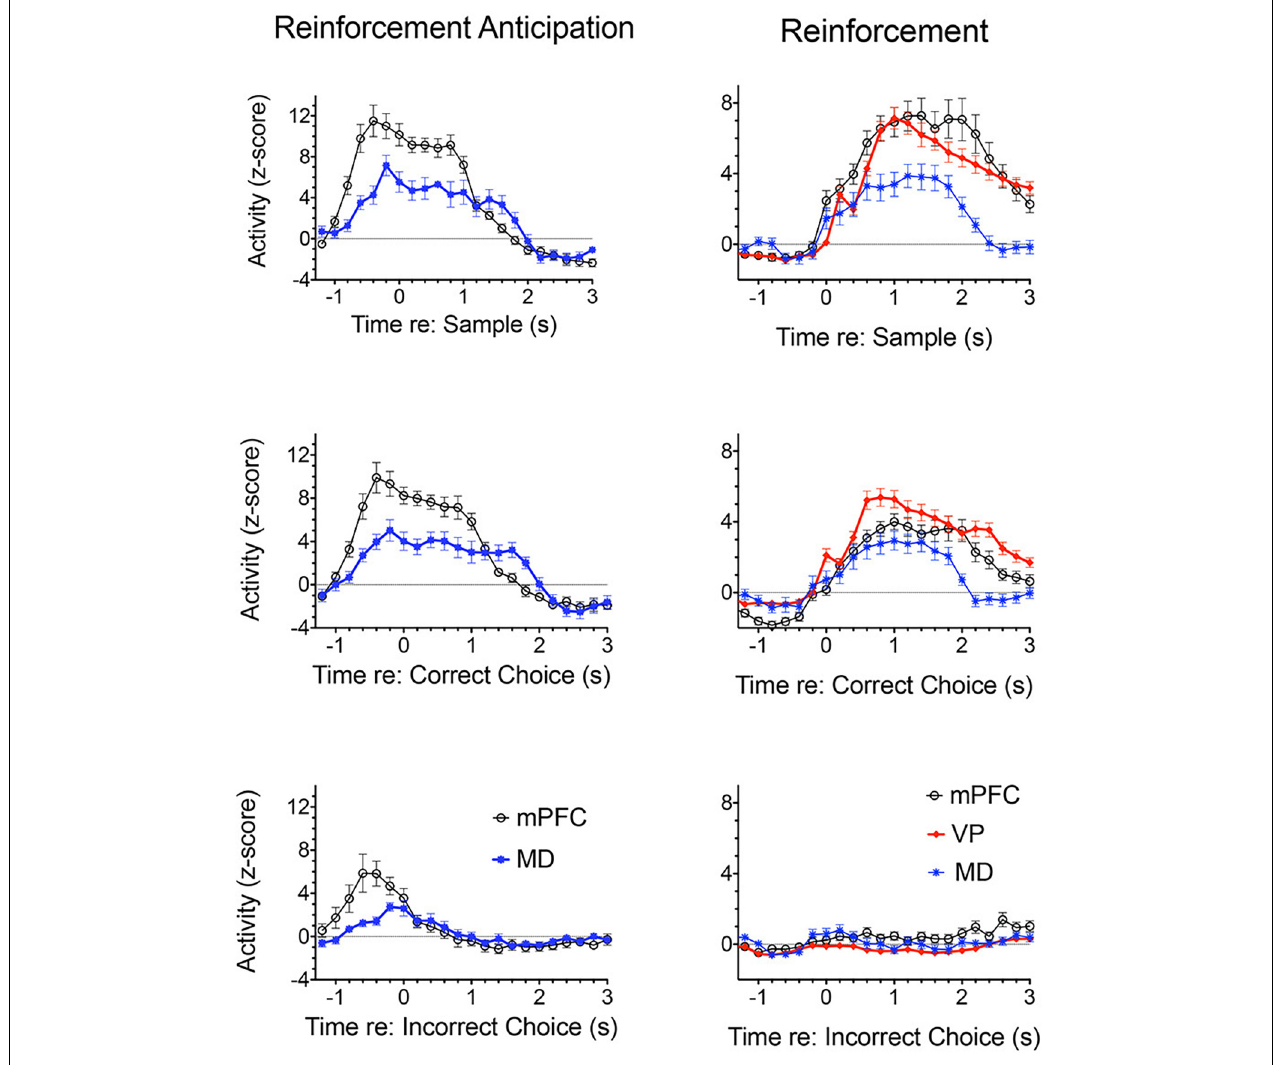
FIGURE 3 | Normalized population histograms responses related to reinforcement delivery in medial prefrontal cortex (mPFC; n = 63), the mediodorsal thalamic nucleus (MD, n = 71), and ventral pallidum (VP, n = 101) and reinforcement anticipation in mPFC ( n = 50) and MD ( n = 46). Anticipatory responses were not observed in VP. Anticipatory responses began on average 0.8 s before rewards were normally delivered and ended 0.2 s after reward delivery ended or 0.2 s errors when rewards were not delivered. Reinforcement responses began 0.2 s after reward delivery began and lasted until 1.0 s after reward delivery ended. Results are shown for all neuronal responses recorded for each response type with a minimum of 40 trials completed in a 60 m session. These were averaged for individual neurons and normalized so that each response recorded contributed equally to the population function. Error bars represent standard error of the